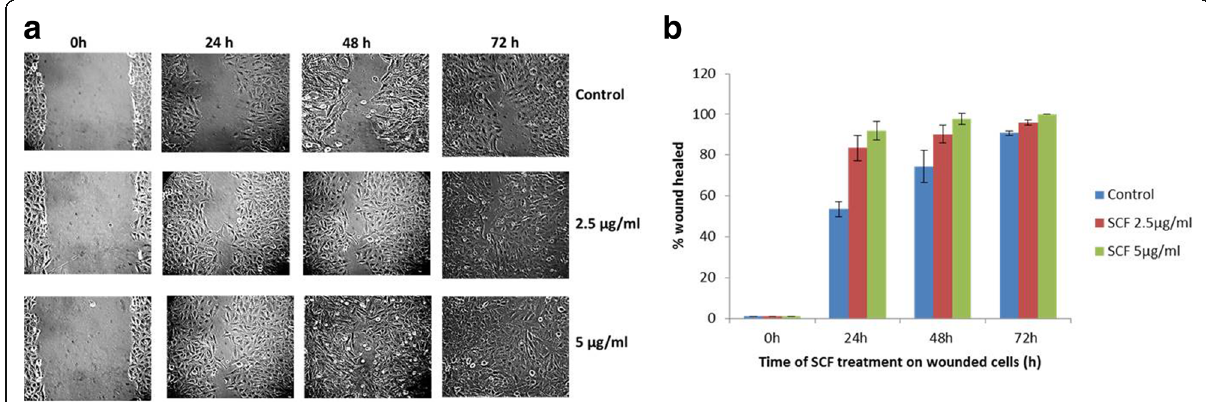
Fig. 12 a Wound healing activity of SCF on A-549 cells. Wounds were created on A-549 cells, and effect of SCF on wound area was estimated. Untreated cells served as control. Wounds healed faster in cells treated with SCF as compared to control; ( n = 4 replicates). b Effect of SCF on healing of wounds created on A-549 cells in vitro. Wound healing ability of SCF was quantified as the % area of the wound healed by different dosages of SCF using ImageJ software. Wounded cells treated with DMEM served as control; ( n = 4